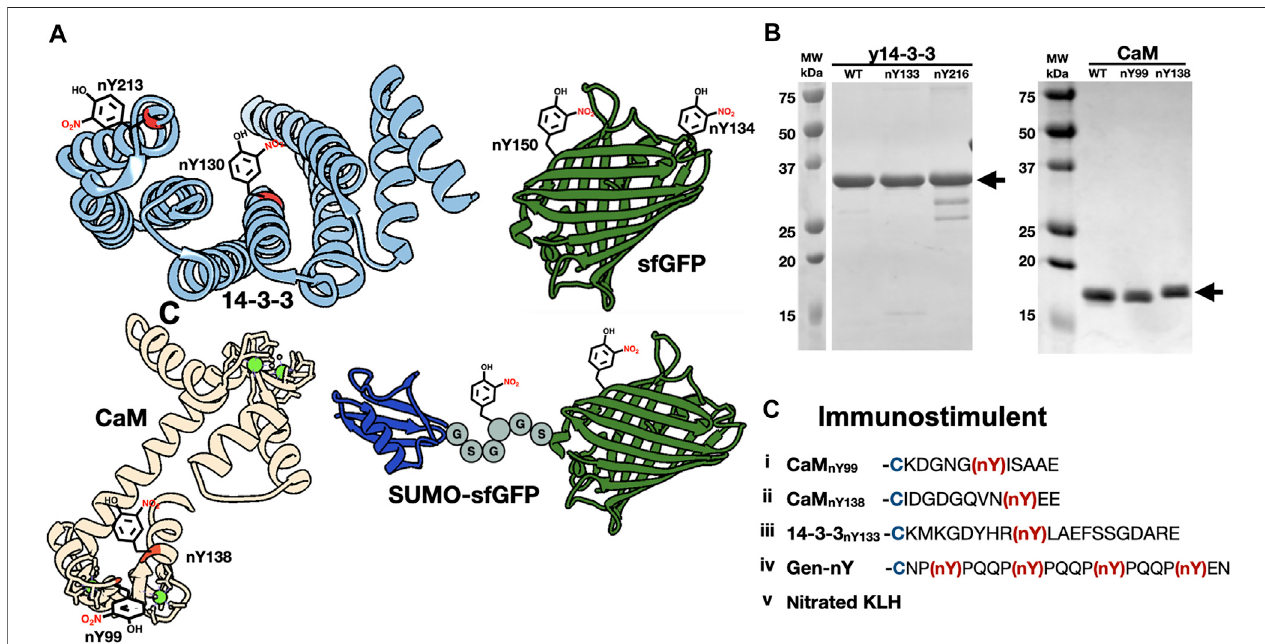
FIGURE1| ThegenerationofnitratedmoleculesforNbselectionsandevaluations. (A) StructuresofnitratedtargetsusedinthisstudyandgeneratedwithChimera. Nitration sites are indicated with nitroTyr drawing. (PDB ID-2BQ0, 3CLN, 2B3P). (B) SDS-PAGE analysis of puri fi ed nitrated targets. (C) Schematic of fi ve immunogens included in injection mixture. Peptides i-iv are conjugated to KLH with a N-terminal cysteine residue (blue). NitroTyrs in peptides are indicated in red.